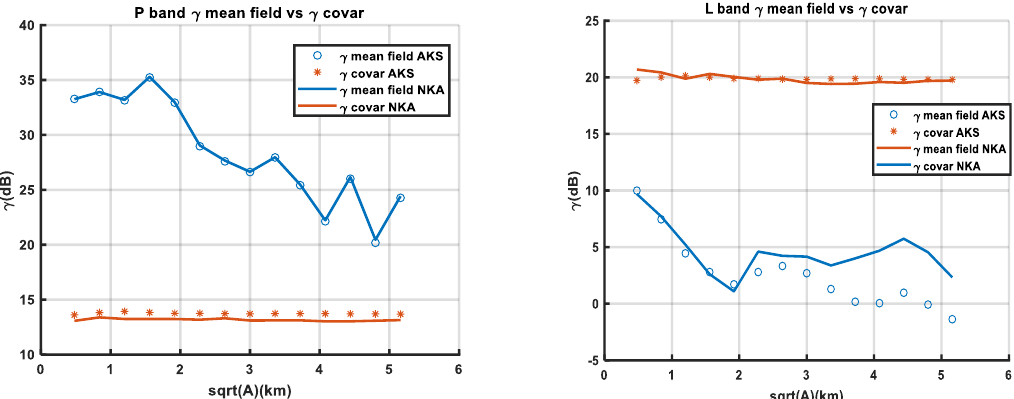
Figure 12. 𝛾 𝑚𝑒𝑎𝑛 𝑓𝑖𝑒𝑙𝑑 and 𝛾 𝑐𝑜𝑣𝑎𝑟 for the L-band and P-band. Results have shown that the NKA has Figure 12. γ mean field and γ covar for the L-band and P-band. Results have shown that the NKA has good agreement with AKS. In the P-band, 𝛾 𝑚𝑒𝑎𝑛 𝑓𝑖𝑒𝑙𝑑 is always much larger than 𝛾 𝑐𝑜𝑣𝑎𝑟 , while for good agreement with AKS. In the P-band, γ mean field is always much larger than γ covar , while for the the L-band, 𝛾 𝑐𝑜𝑣𝑎𝑟 is much larger than 𝛾 𝑚𝑒𝑎𝑛 𝑓𝑖𝑒𝑙𝑑 . L-band, γ covar is much larger than γ mean field